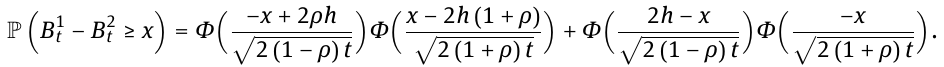
Figure 2 represents the survival function of B 1 value of this function is close to 0.7 when x is close to 0 at time t = 1. However, when t = 20, it becomes close to 1 and the asymmetry 2